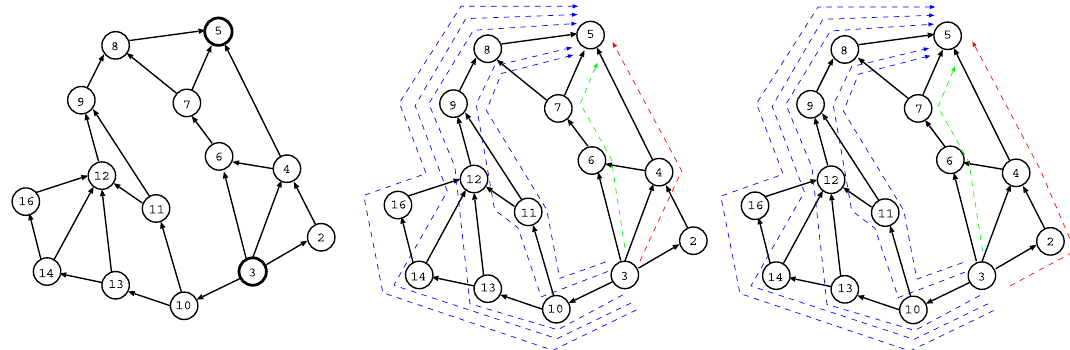
Figure 5. Example of k = 3 non-intersecting paths from 3 to 5. Three non-intersecting paths are colored by red, green, and blue. (Left) A part of directed graph, (Middle) five combinations of the paths, (Right) other five combinations of the paths. Note that only red line is different via vertex